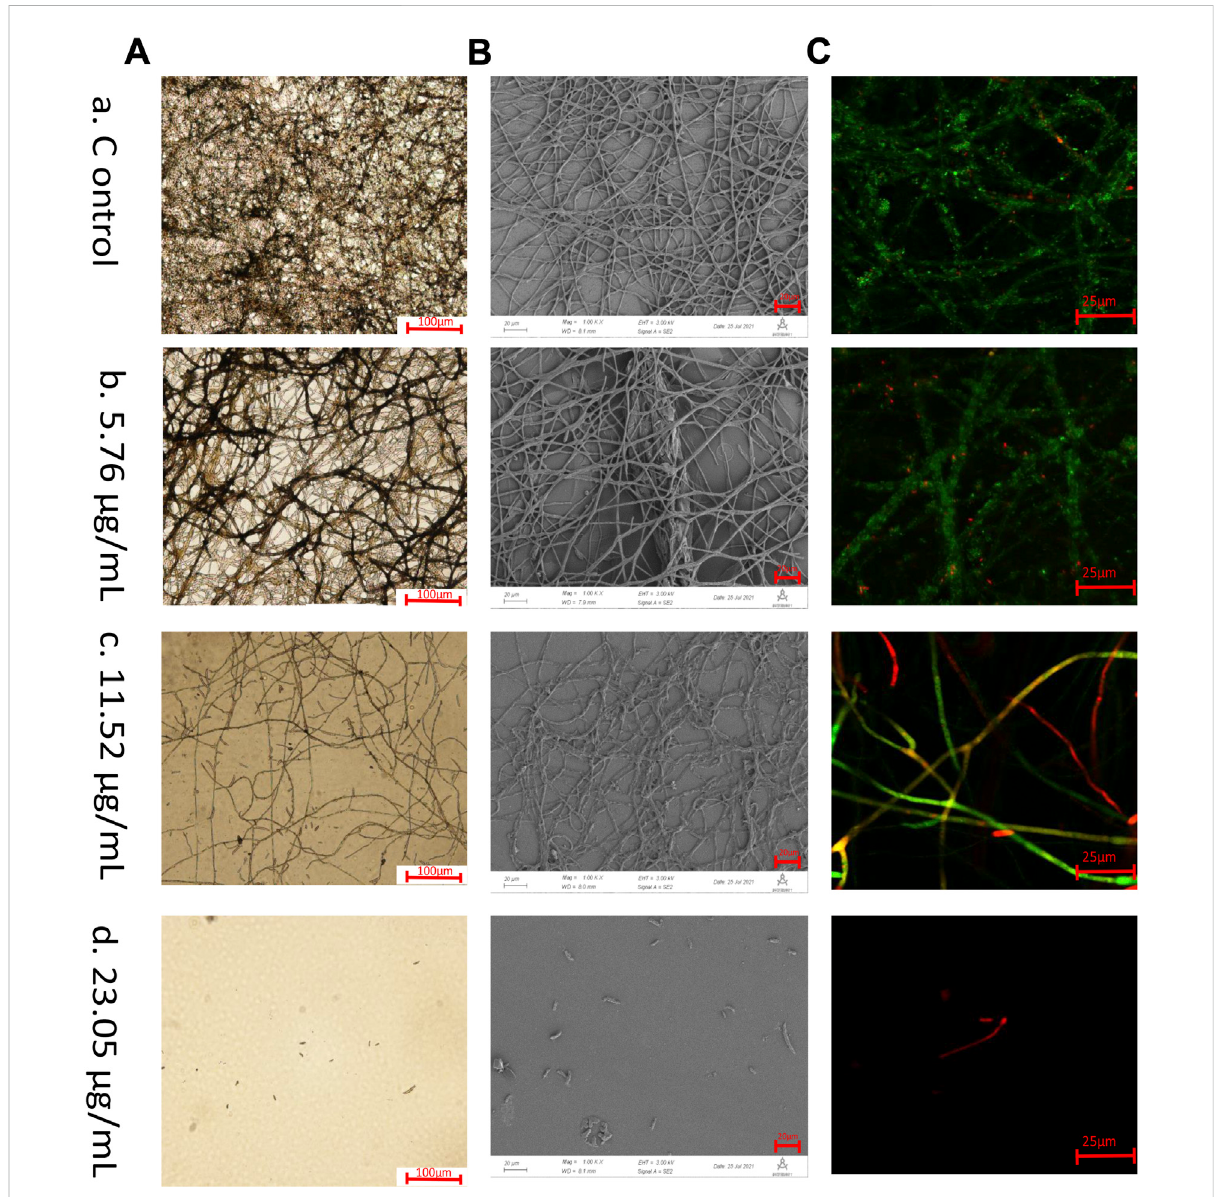
FIGURE 2 Microscopic observation. Bio fi lms of F. solani species complex are visualized by different microscopic techniques. The F. solani species complex cells were transferred to RPMI 1640 media with different concentrations of 1,8-cineole at 27 ° C for 72 h. The samples were treated at (A) 5.76 μ g/ml, (B) 11.52 μ g/ml, (C) 23.05 μ g/ml, and (D) 46.1 μ g/ml of 1,8-cineole, respectively. (A) Optical microscopic images of bio fi lm formation under 1,8-cineole treatment. Scale bar is 100 μ m (100x). (B) Scanning electron microscopy images of bio fi lm formation under 1,8-cineole treatment.Scalebaris20 μ m(1,000x).The arrowindicatedthatthebio fi lmhasmultilayer myceliumstructure. (C) CLSMimagesofbio fi lmformation under 1,8-cineole treatment. NucGreen is green nucleic acid staining and EthD-III is red nucleic acid staining. Red represents dead cells, green represents living cells, and yellow represents weakened cells Scale bar is 25 μ m